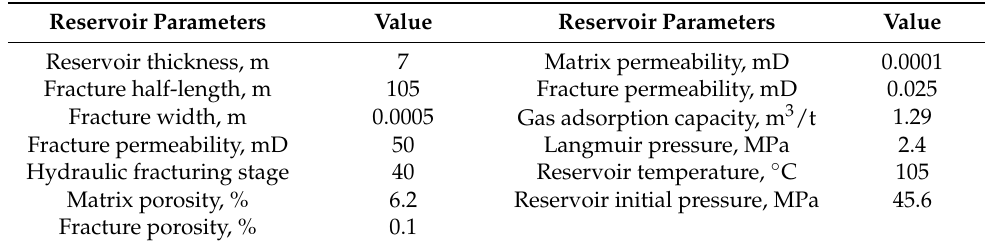
Figure 5. Shale gas adsorption curve of W Block based on experiments. To analyze the effect of different parameters on well interference, the following sce- narios are set for further discussion. The summary of the model setup of different scenar- ios is tabulated in Table 2. Table 2. The summary of the model setup of different scenarios. Well interference caused by hydraulic fracturing of neighboring wells Scenario 1